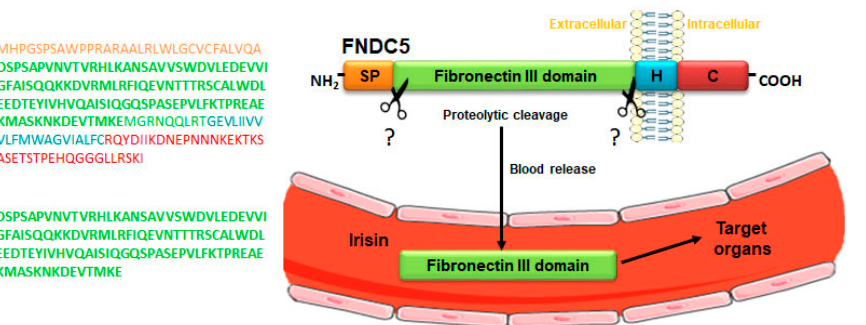
Figure 1. Mechanism of irisin release into the blood. Schematic structure of irisin precursor fibronectin type III domain-containing protein 5 (FNDC5) and its amino acid sequence (upper panel). FNDC5 cleavage, by a yet unknown enzyme at levels of the extracellular domain, gives rise to the release of irisin into the blood, a peptide consisting of a sequence of 112 amino acids (lower panel). Abbreviations: SP, signal peptide; H, hydrophobic domain; C, cytoplasmic domain. Symbols: ? indicates the unknown enzyme.